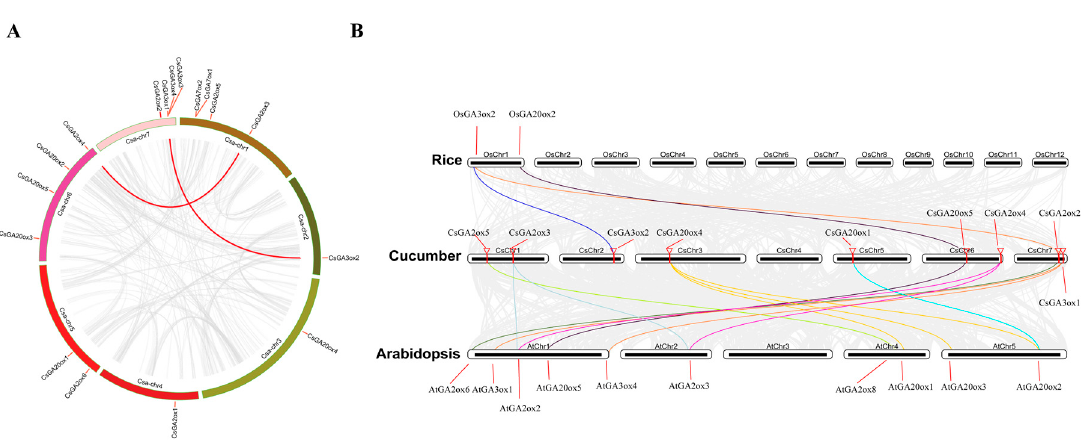
Table 1. Candidate transcription factors binding promoters of CsGAoxs identified by PlantRegMap.